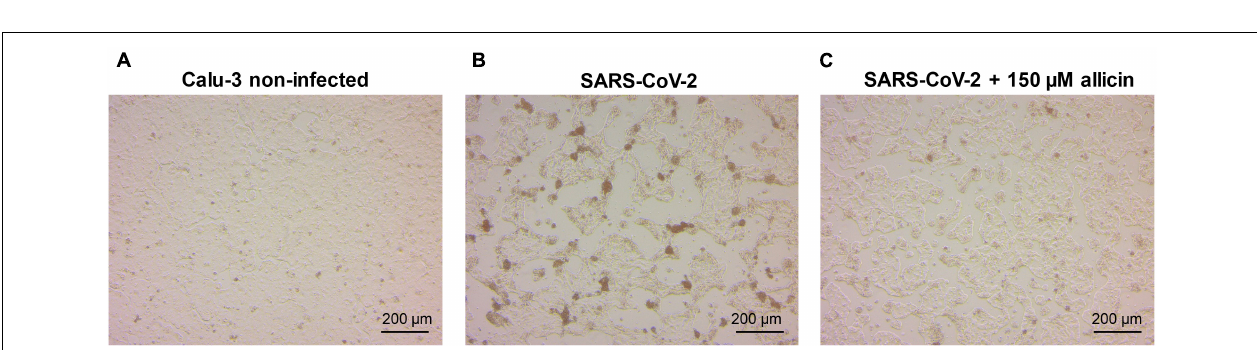
FIGURE 3 | Allicin treatment of SARS-CoV-2 infected Calu-3 cells leads to decreased amounts of infectious viral particles and viral RNA. (A–D) SARS-CoV-2 infected Calu-3 cells were treated with 100 and 200 µ M allicin p.i. The amount of viral RNA (A,B) and infectious viral particles (C,D) was determined 16 h (A,C) and 24 h (B,D) p.i. with SARS-CoV-2 at a MOI of 0.01 (A,C) and 0.005 (B,D) . The results are from three biological replicates with two technical replicates for panels (A,B) . Error bars represent the SD. p -values were calculated using an unpaired two-tailed t -test. * p < 0.05.